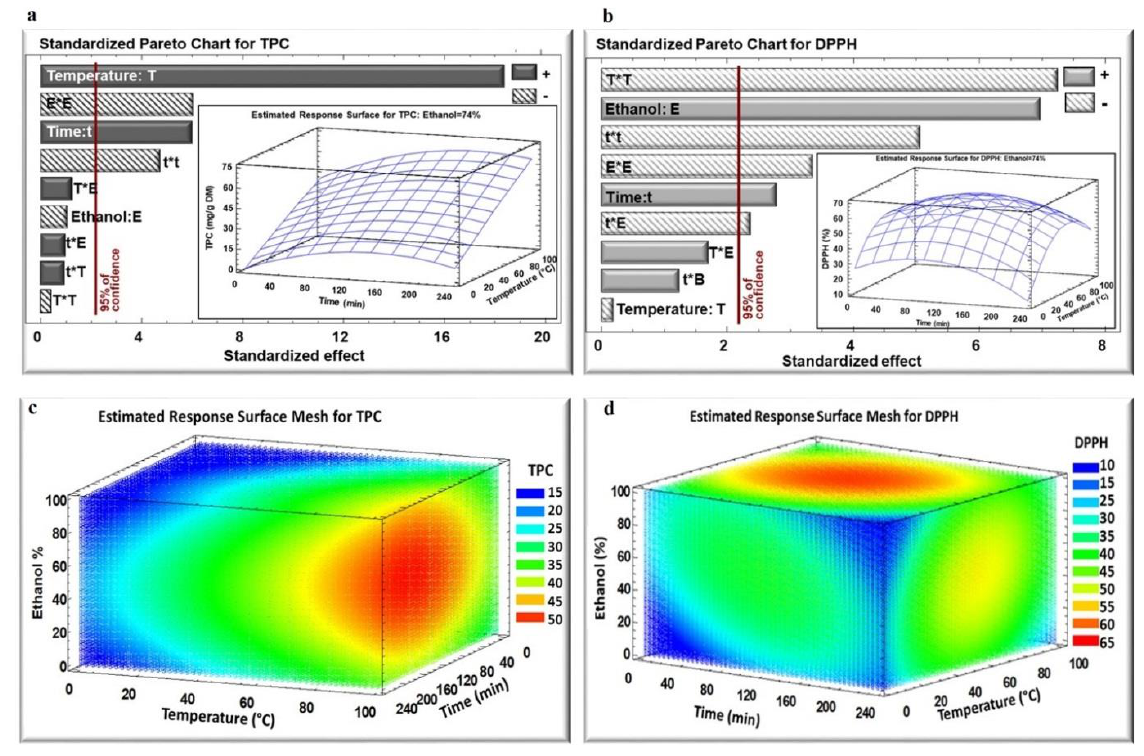
Figure 2. Standardized Pareto Chart for TPC ( a ) and DPPH ( b ) inhibition percentage for WB extraction, and estimated response surface Mesh for TPC ( c ) and DPPH ( d ) inhibition percentage. (+) indicates positive effect, ( − ) indicates negative effect.